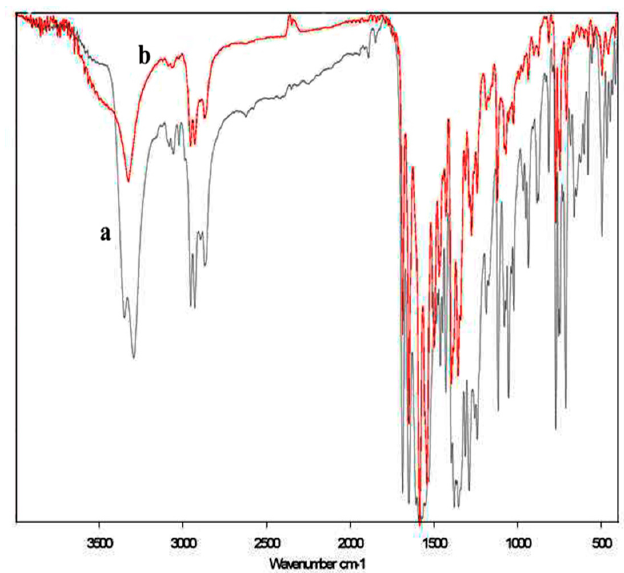
Figure 12. IR spectra of compound L before (a) and after (b) the addition of Cu 2+ .